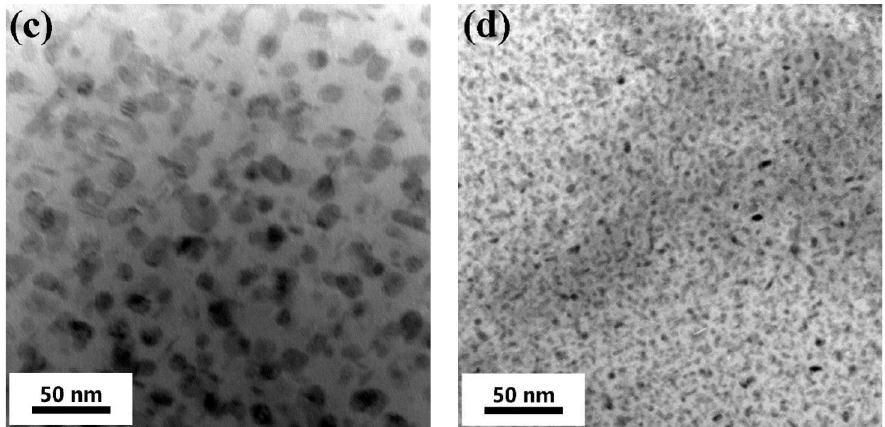
Figure 5. Transmission electron microscope (TEM) bright field images for intragranular precipitates of creep aged AA7050 under 165 °C and different stress levels: ( a ) 300 MPa for 2 h; ( b ) 300 MPa for 4 h; ( c ) 300 MPa for 12 h; and, ( d ) 350 MPa for 3 h.